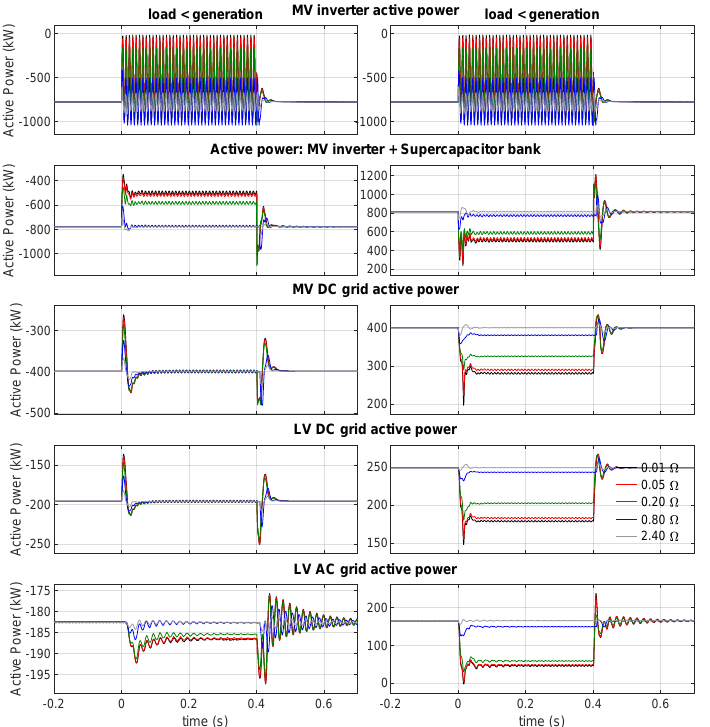
Figure 22. Active power in the ST’s MV inverter and hybrid AC/DC sub-networks following unbalanced phase–phase faults in the HV AC grid for the considered fault resistances. For the remaining cases, the hybrid AC/DC grid remains practically immune to the adverse impacts of the grid faults in the upstream MV AC grid. During net generation scenarios (load < generation), the generation in excess is dissipated in the dump-load, not existing necessity for the FRT control to modulate the voltages in the hybrid AC/DC grid, which are kept around their nominal values (excepting the brief transitory variations in the start and end of the voltage sags). As shown in Figure 22—MV inverter active power, the active power in the ST’s MV inverter gets reduced during net generation scenarios where the current in the ST’s MV inverter reaches its limits of 1 p.u. Only power-frequency sensitivity is exploited in the LV AC sub-network during net generation scenarios when the current levels in the ST’s MV inverter reach the saturation level of 1 p.u., so the existing controllable ESS increases/reduces its active power charging/discharging to save some of the net generation surplus (Figure 23—Storage). The power oscillation observed in the LV AC grid after the fault clearance are due to the same reasons already explained in Section